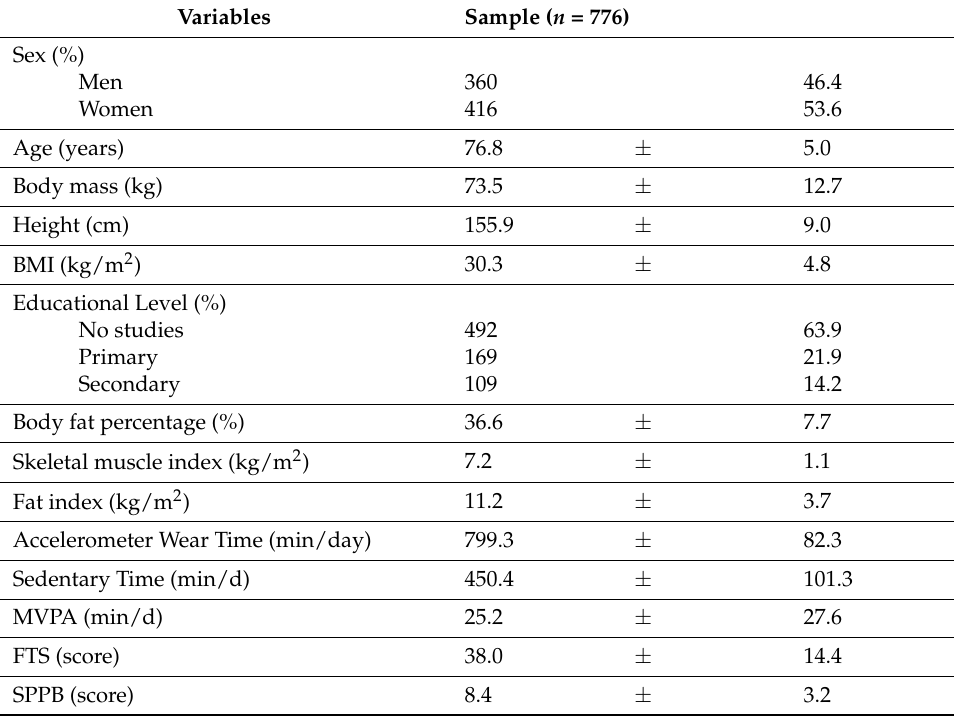
Table 1. Anthropometric and descriptive data.